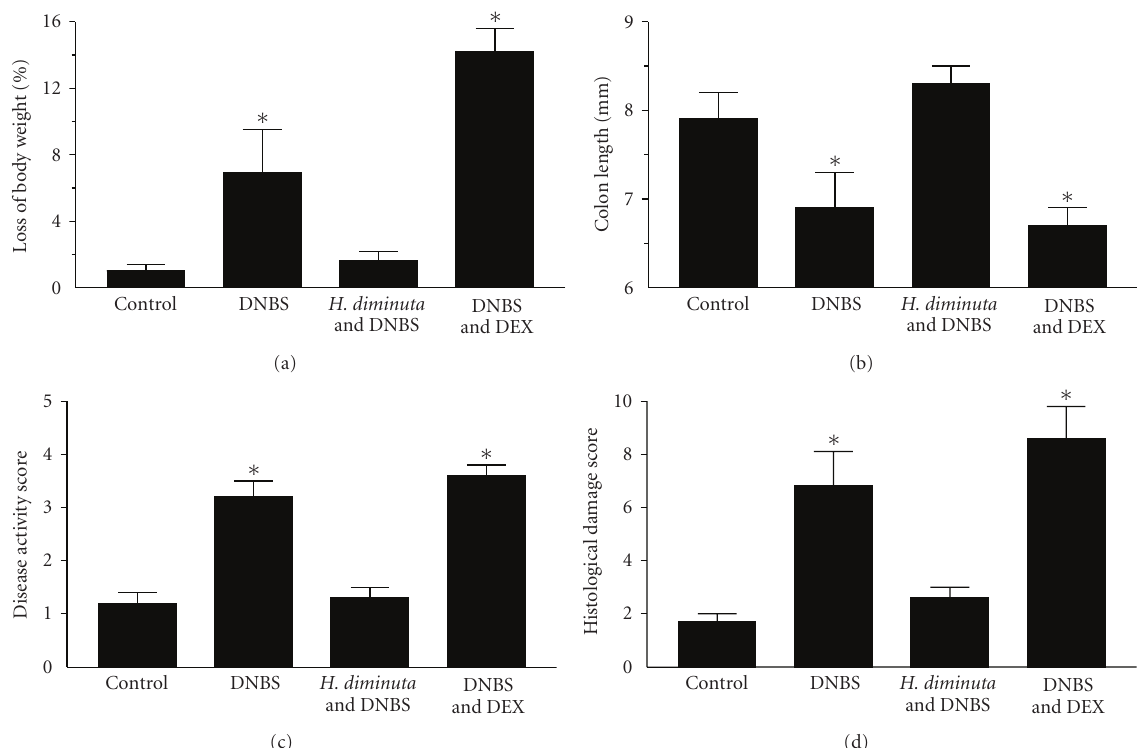
Figure 1: Bar graphs showing that infection with H. diminuta 8 days prior to DNBS (ir., 2.5mg), in contrast to 3 doses of dexamethosone (DEX), reduces the severity of colitis as gauged by (a) body weight, (b) colon length, (c) disease activity scores, and (d) histological damage scores (mean ± SEM; n = 6–8 mice from 2 experiments; ∗ P < . 05 compared to